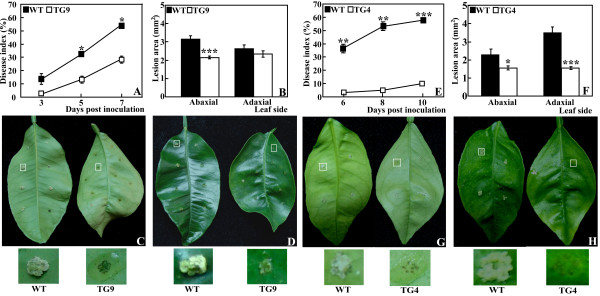
Canker disease tolerance assay of the wild type (WT) and the transgenic lines (TG4 and TG9). Disease index (A, E) and lesion area (B, F) of WT, TG9 (A-D) and TG4 (E-H) after inoculation with Xac. Comparison between TG9 and WT, TG4 and WT was done in different inoculation experiment. Asterisks show that the values are significantly different compared with the control (* for P < 0.05, ** for P < 0.01 and *** for P < 0.001). Representative photographs showing symptoms on the abaxial (C, G) and adaxial (D, H) sides of the leaves from WT/TG9 (C-D) and WT/TG4 (G-H). Selected inoculation sites of the leaves were zoomed in and shown below the corresponding photos.